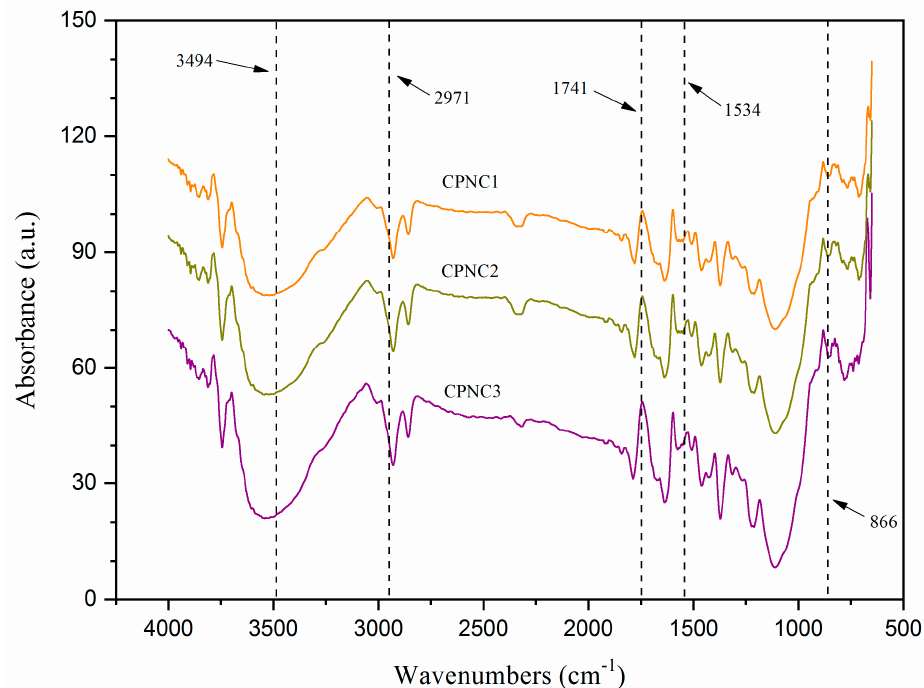
Figure 3. FTIR spectra of CPNC1, CPNC2 and CPNC3.